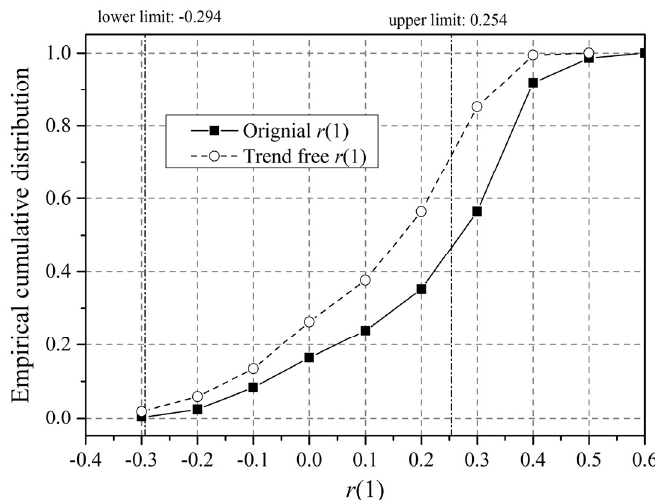
Figure 9. The empirical cumulative distribution of r (1) values estimated from potential evapotranspiration (PET) data.